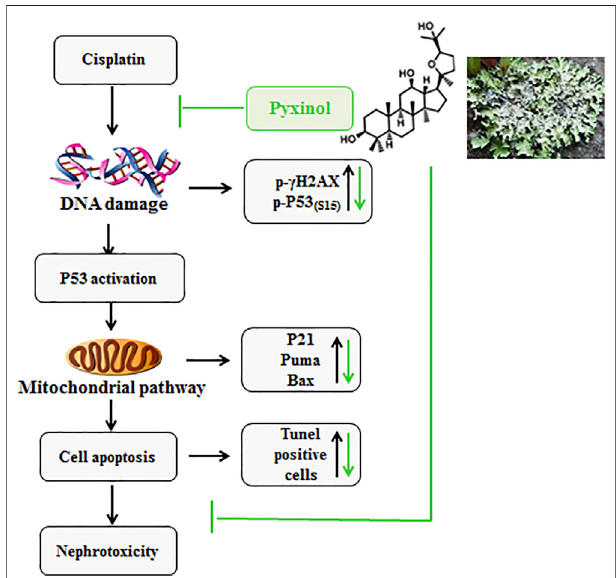
FIGURE 8 | The working